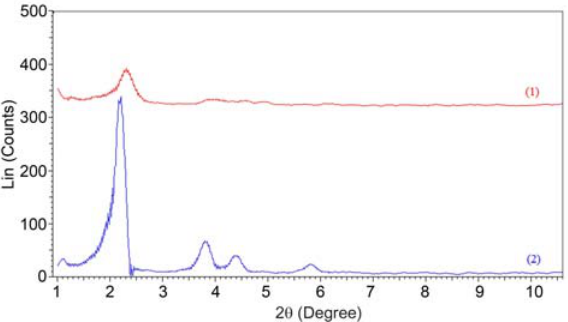
Figure 1. XRD patterns of the parent (1) L-prol-N-pMCM-41 and (2)